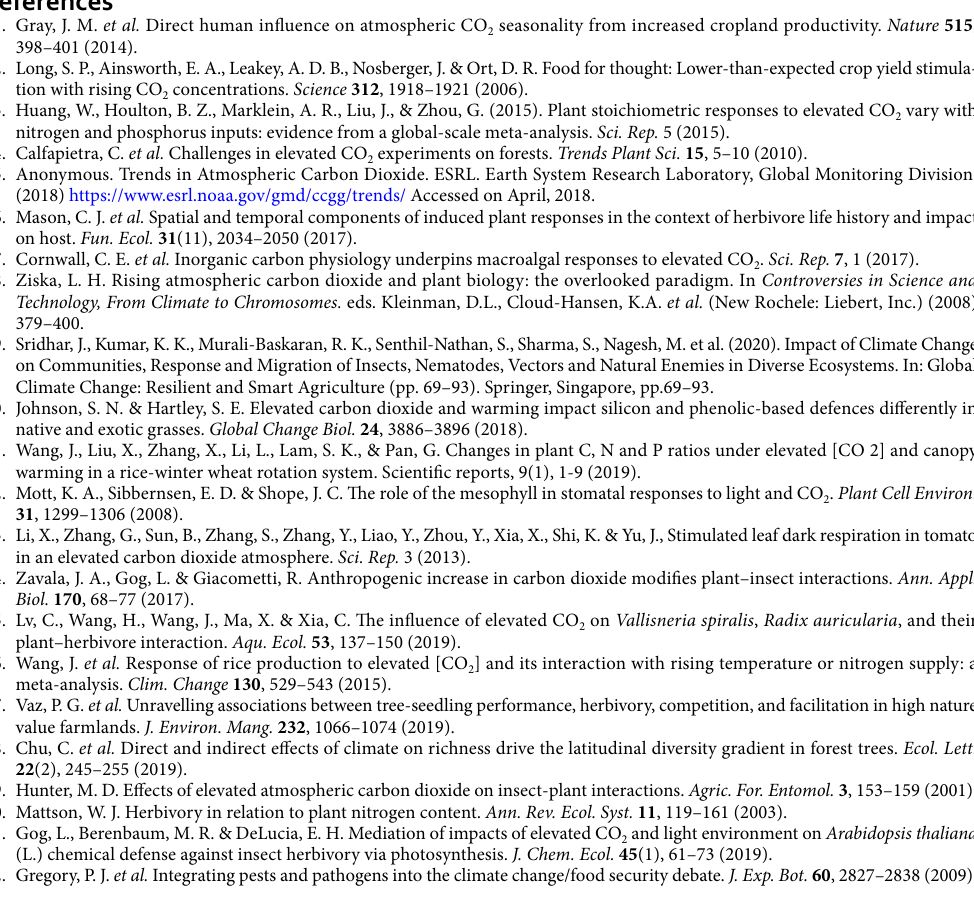
Statistical analysis. Biology and nutritional indices were recorded as the mean of four replications and normalized by arcsine-square root transformation of percentages. The transformed percentages were undergone to analysis of variance (ANOVA). Differences between the five treatments were determined by Tukey’s–Kramer